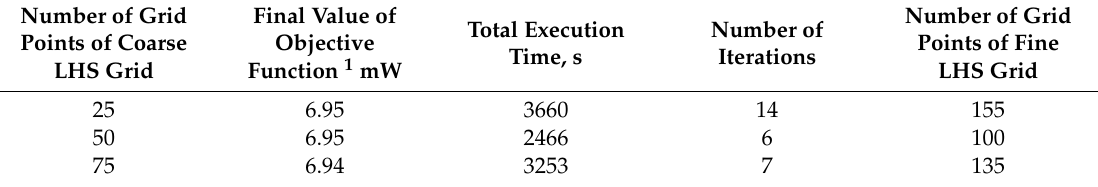
Table 3. Results of optimization using Strategy